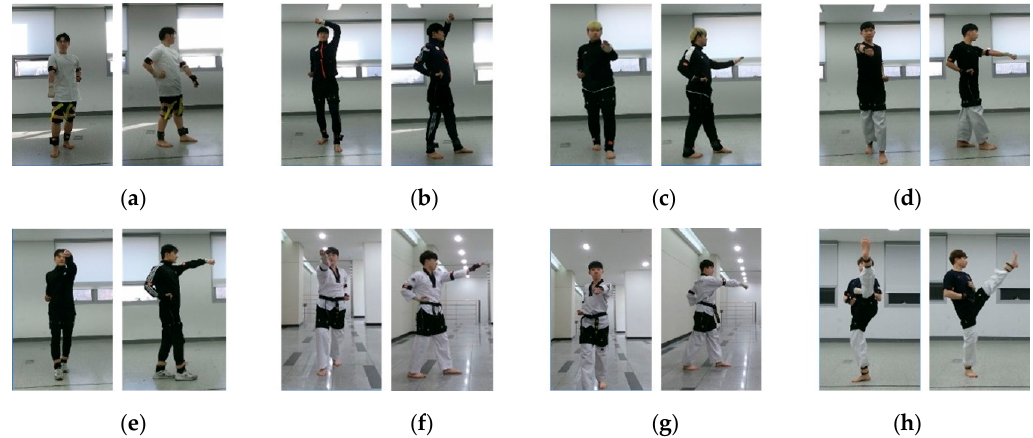
Figure 5. Eight taekwondo actions in TUHAD: ( a ) arae makki (low block, A1), ( b ) eolgul makki (high block, A2), ( c ) sonnal makki (knife hand block, A3), ( d ) momtong jireugi (middle punch, A4), ( e ) eolgul jireugi (high punch, A5), ( f ) sonnal mokchigi (knife hand strike, A6), ( g ) dubeon jireugi (double punch, A7), and ( h ) abchagi (front kick, A8). All actions were recorded with two camera views.